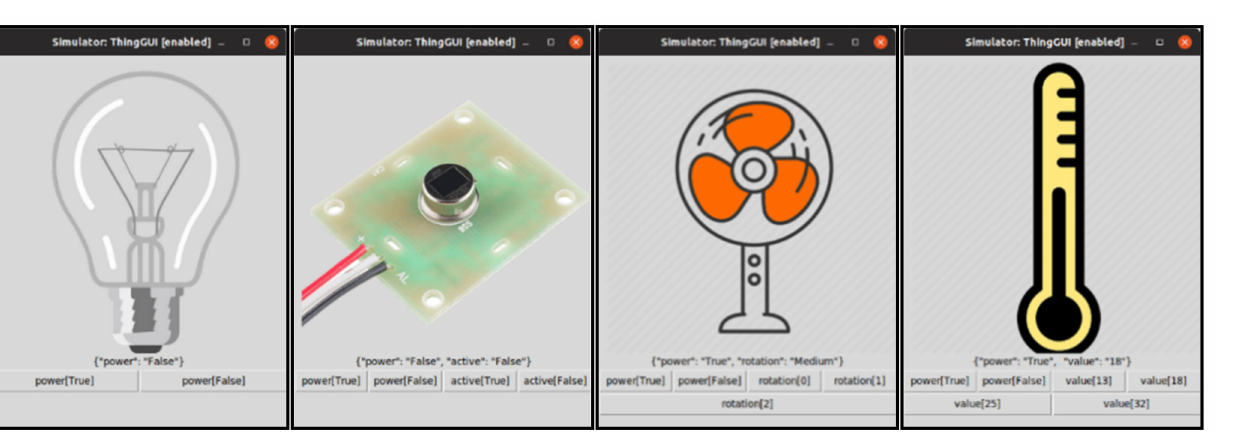
Figure 7. Two-dimensional environment virtual devices with associated profiles. From left to right: a lamp that can be turned on and off, a passive infrared (PIR) sensor that randomly changes its state at 30 s intervals from idle to activated and vice versa, a fan with three levels of rotation and a temperature sensor with four heat levels that randomly toggles each 60